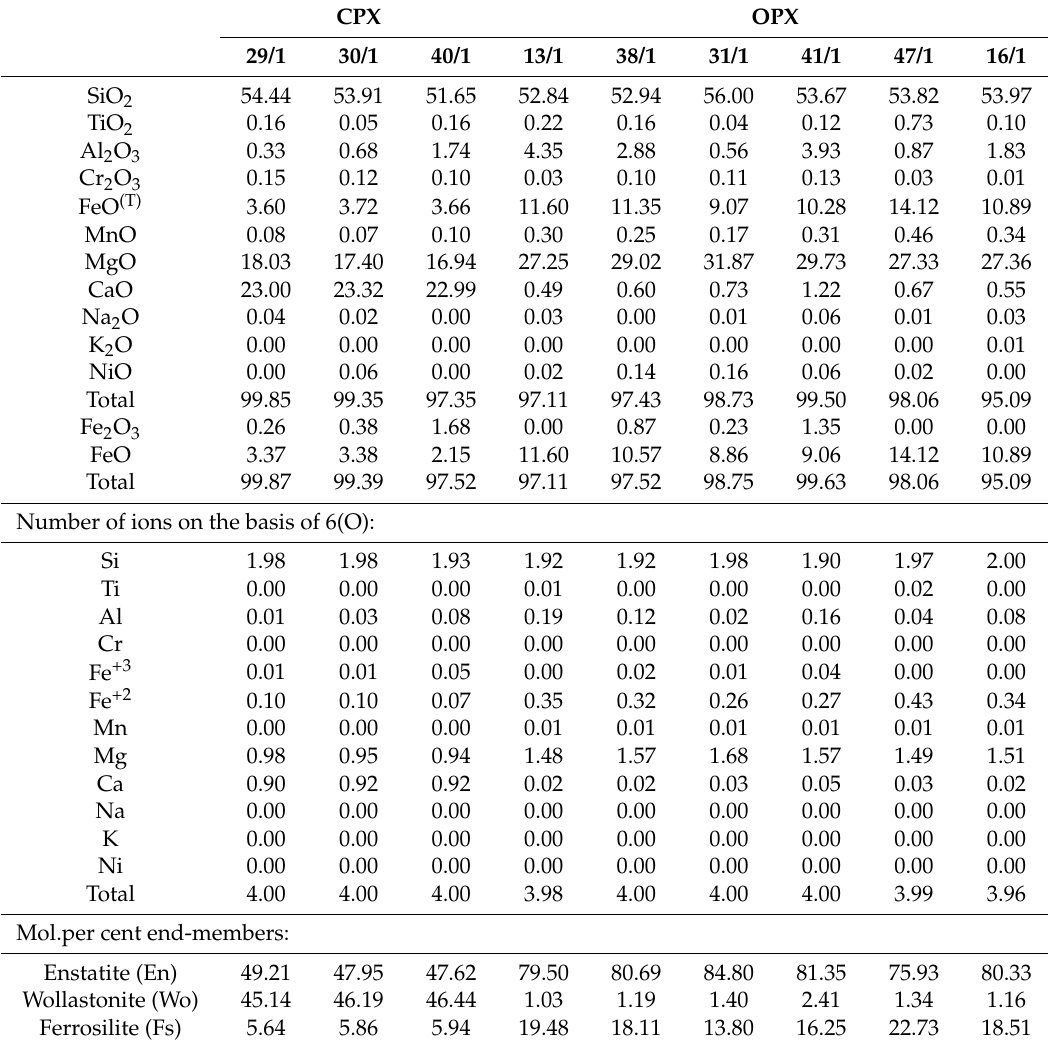
Table 1. Mineral composition of the clinopyroxene (CPX) and orthopyroxene (OPX) phases present in the Holenarsipur